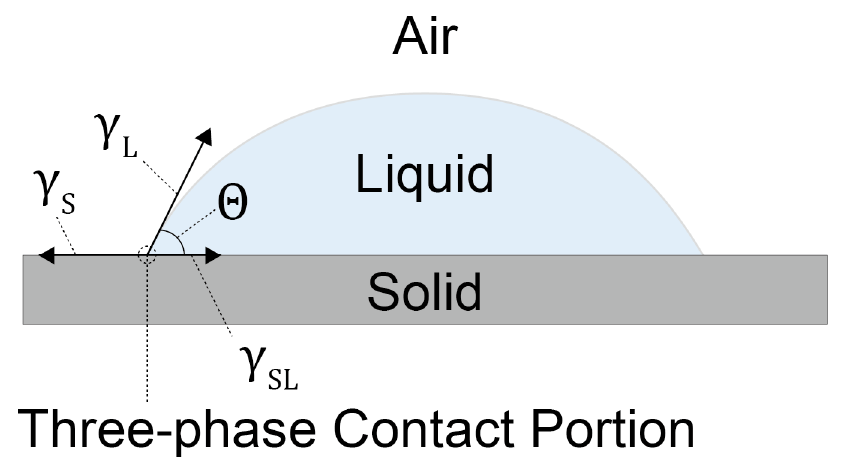
Figure 4. A schematic diagram of a dropped liquid on a solid surface. The arrows at the three-phase contact portion indicate each interfacial tension.